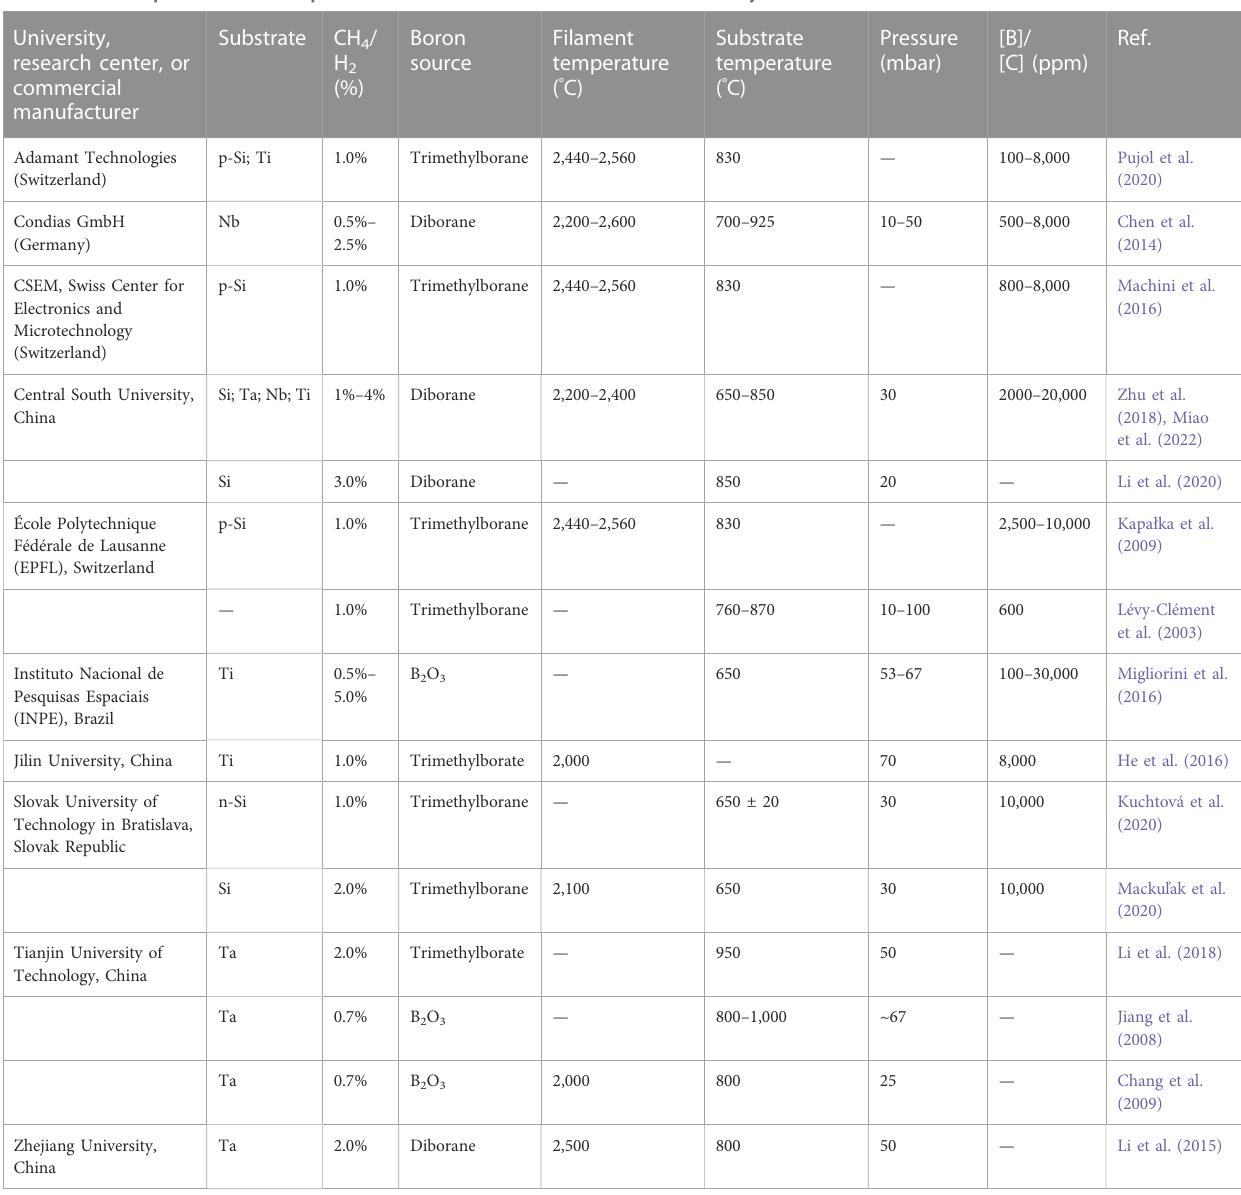
TABLE 1 HFCVD deposition conditions present in the literature based on the bibliometric analysis search. University, research center,